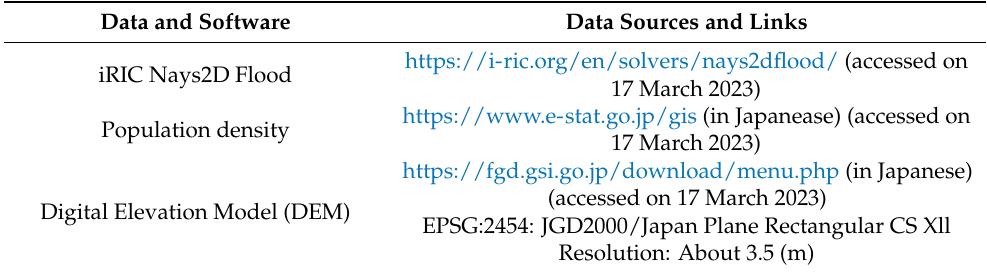
Table 1. Details of the data and the software used in this